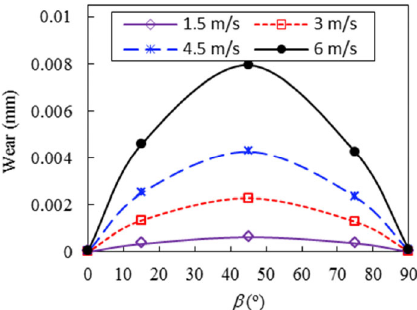
Fig. 16 Variation of the flow erosion versus the angle of the surface inside the flow, at different speeds.